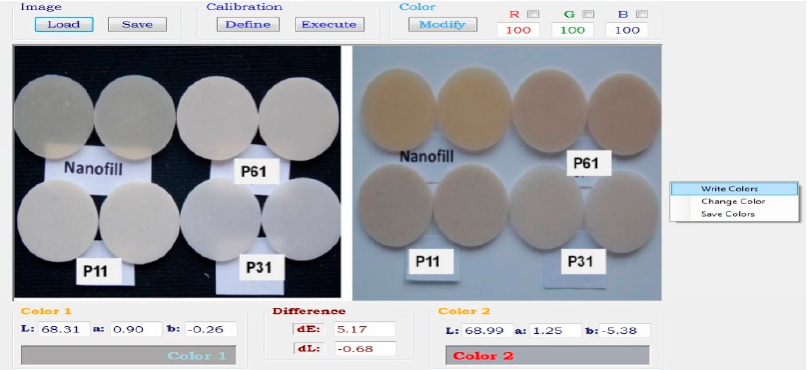
Figure 2. Digital images used for color difference ( Δ E ab ) by applying the original software (Dentcolor application), initial and after coloring.